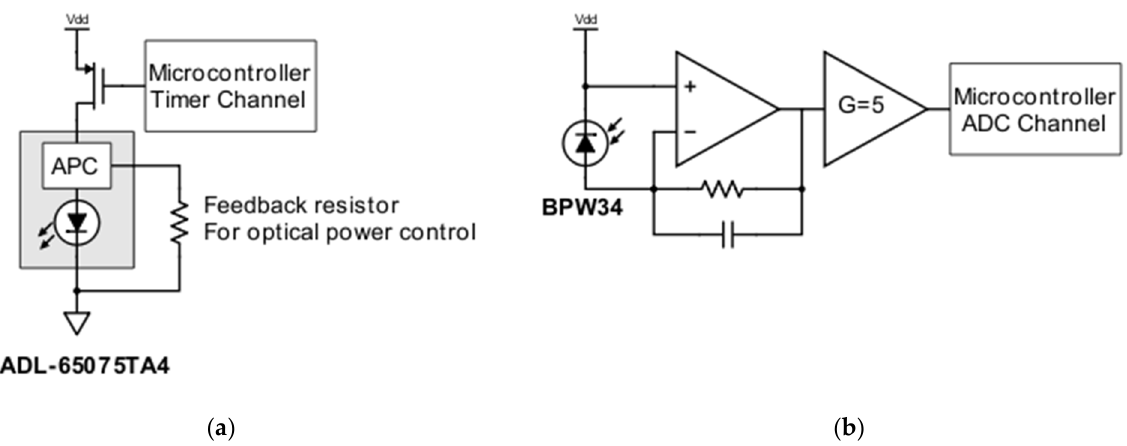
Figure 2. ( a ) Laser pulse generation circuit diagram including the APC unit; and ( b ) circuit diagram of the receiver.